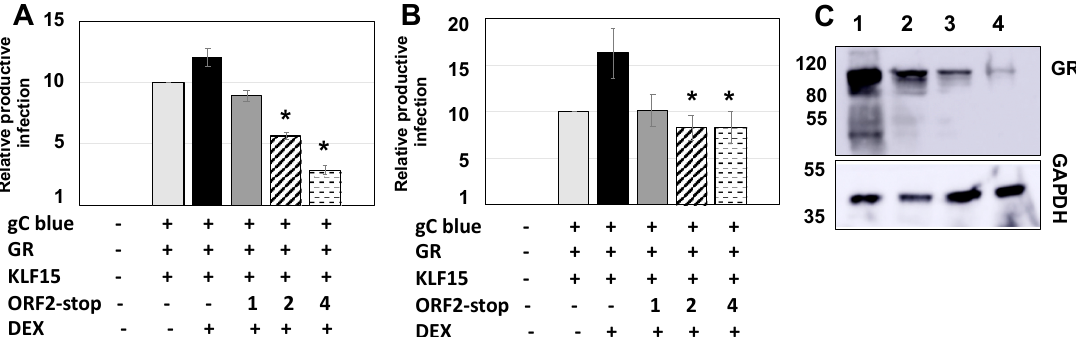
Figure 3. Latency-related (LR) ORF2 RNA sequences interfere with productive infection and reduce GR steady-state protein levels. Panel ( A ): Neuro-2A cells were transfected with 1.5 ug BHV-1 gC-Blue, and where indicated, a plasmid-expressing mouse GR protein (1.0 ug DNA), Krüppel-like transcription factor 15 (KLF15) (0.5 ug DNA), and ORF2-Stop (1, 2, or 4 ug plasmid). To maintain the same amount of DNA in each sample, an empty vector was included in samples. After